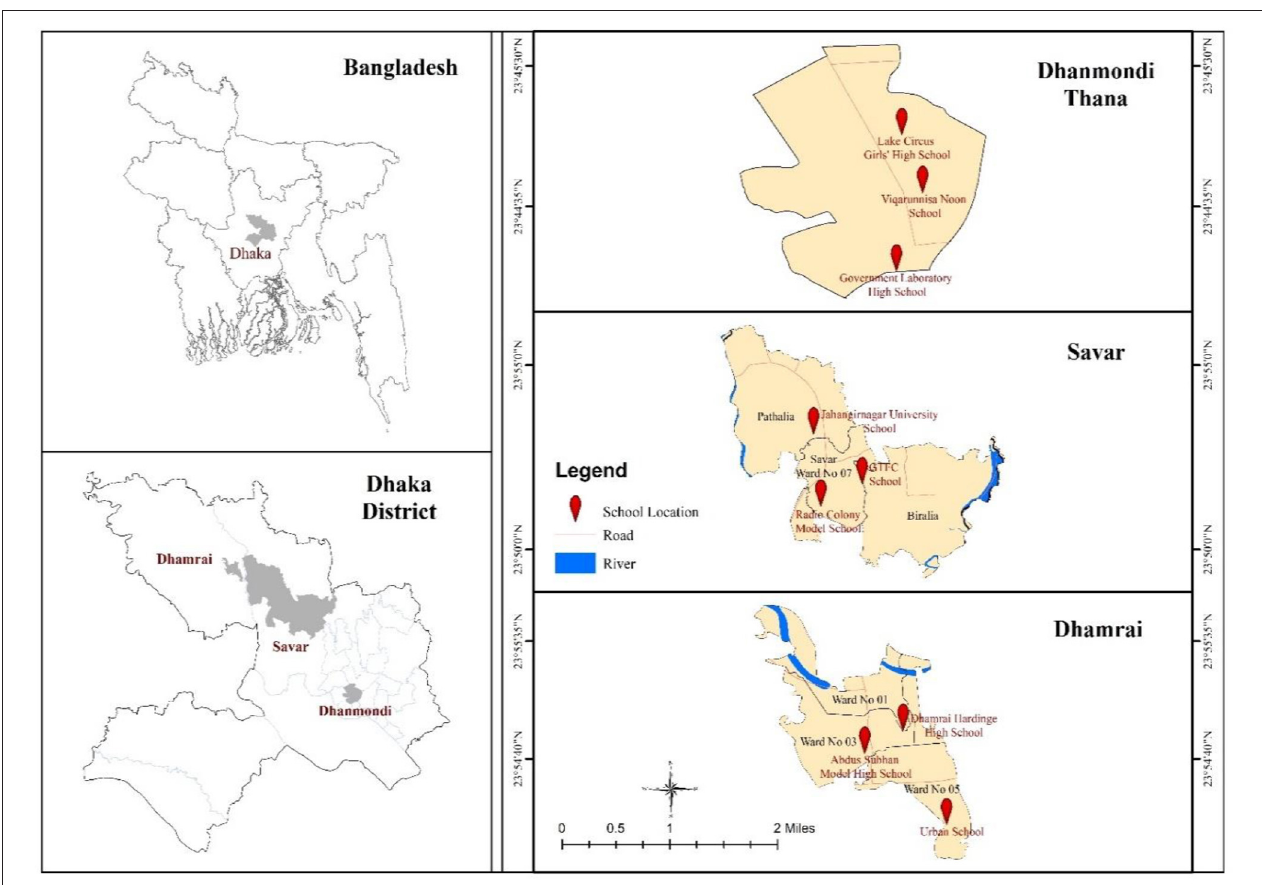
FIGURE 1 | Location map of the study